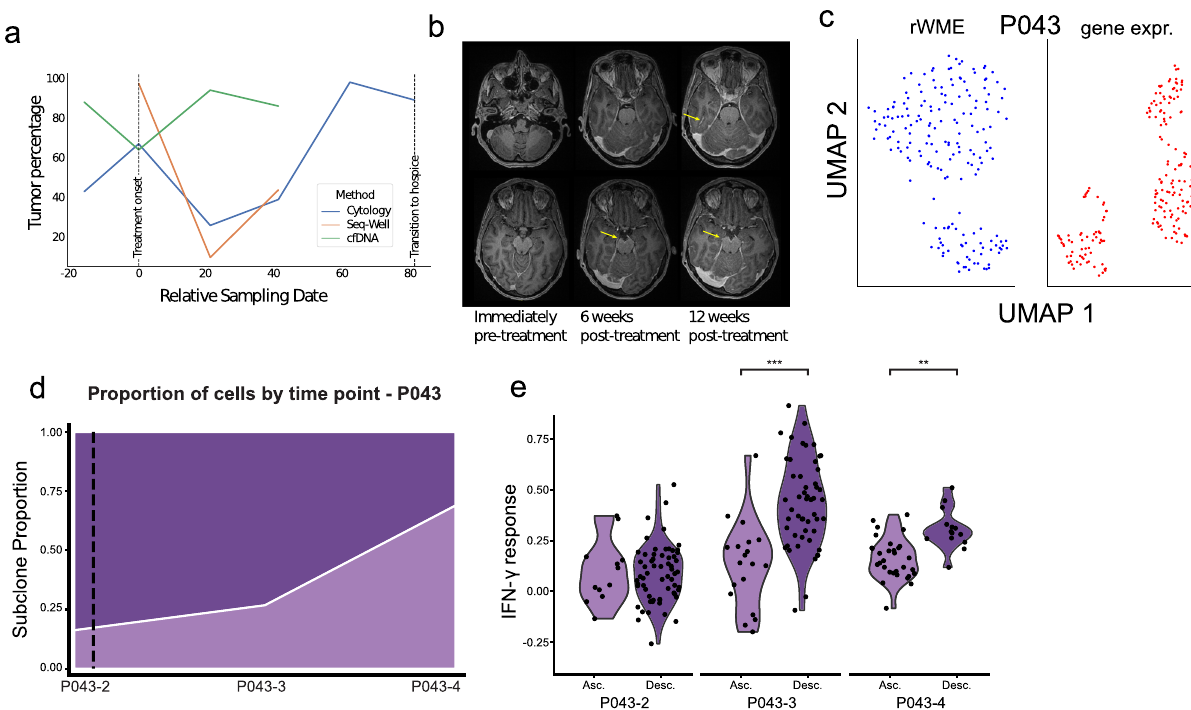
Fig. 4 Longitudinal scRNA and cfDNA from P043 suggest the adaptive selection of a less-immunogenic over a more-immunogenic subclone. a Tumor fraction within CSF, as measured by Seq-Well and cytology, overlaid with tumor purity inferred by ABSOLUTE run on CSF-derived cfDNA. b MRI imagery at 0, 6, and 12 weeks relative to treatment; LMD-indicative enhancement indicated by red arrow. c Unsupervised clustering of inferred copy number pro fi les (left, see Methods) and expression (right) reveals intercellular heterogeneity, possibly explainable by the presence of subclones. d Relative proportions of subclones as a function of time. Darker purple and lighter purple denote the descendant and ascendant subclone, respectively. e IFN- γ response expression in subclones over time (*** p = 0.001, ** p = 0.01, Wilcoxon ranked-sum test, Cohen ’ s d = 1.4, N = 52 for descendent, 19 for ascendant at P043-3; Cohen ’ s d